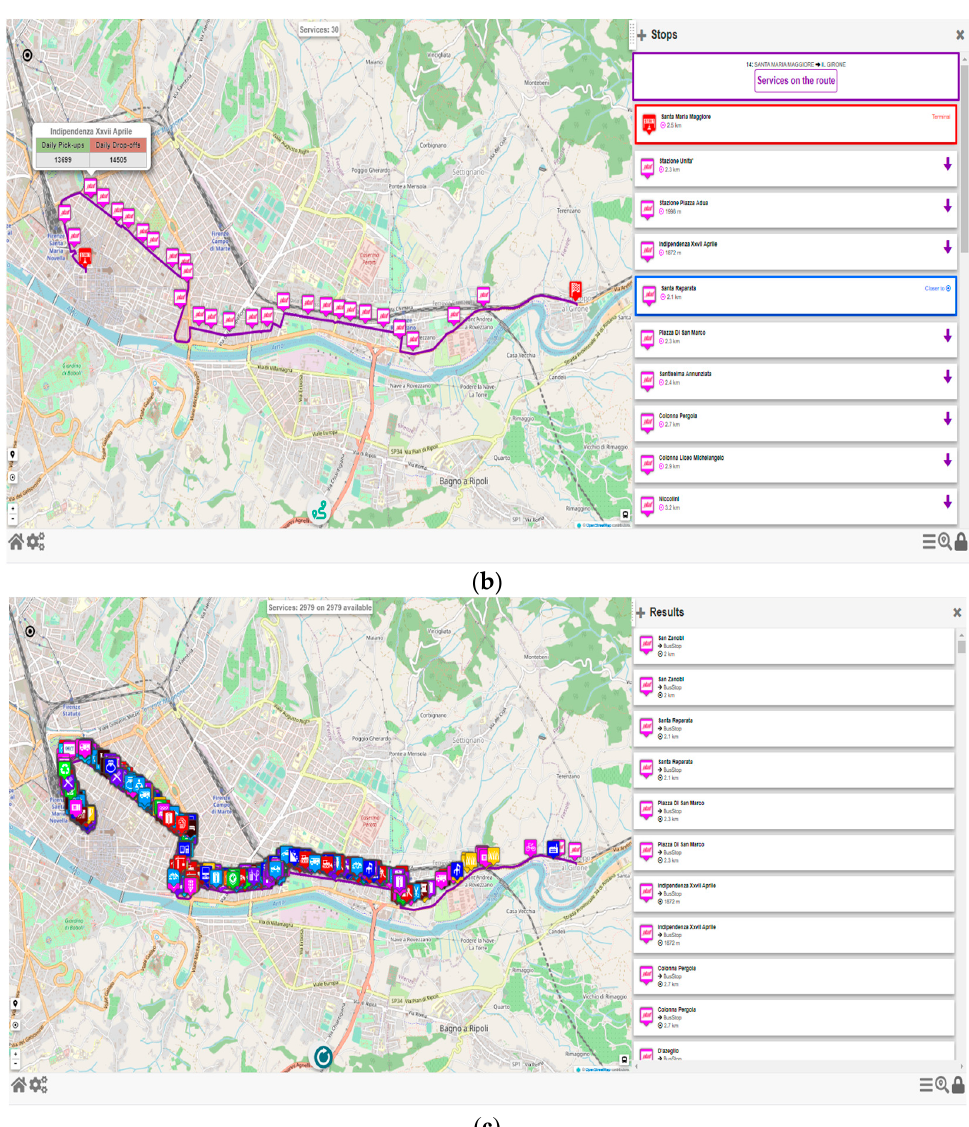
Figure 11. Examples of evidence information: ( a ) pick-ups, drop-offs, and vehicle trips, ( b ) Line information, ( c ) Line nearby services.